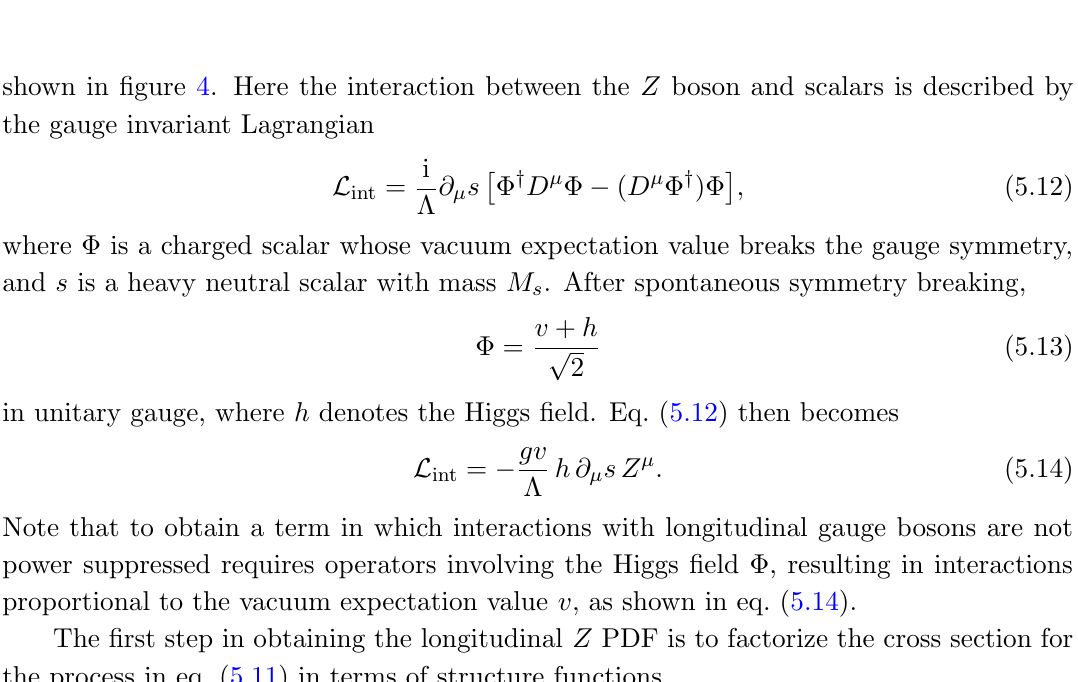
Figure 4 . Feynman diagram for heavy scalar production via Higgs-proton scattering h + p ! s + X .